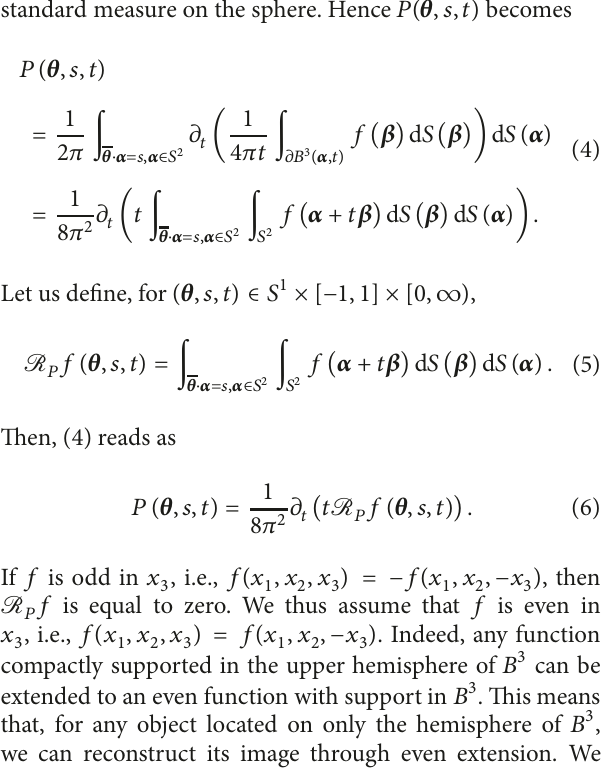
2 where 𝜃 = ( 𝜃 , 0) ∈ 𝑆 and d 𝑆 (everywhere in the text d 𝑆 denotes the measure either on the circle or on the sphere; the dimension will be clear from the context) is the measure on the unit circle 𝑆 1 . The shape of detectors is the circle which lies in a plane perpendicular to 𝜃 with distance 𝑠 from the origin (see Figure 1). Also, it is a well-known fact